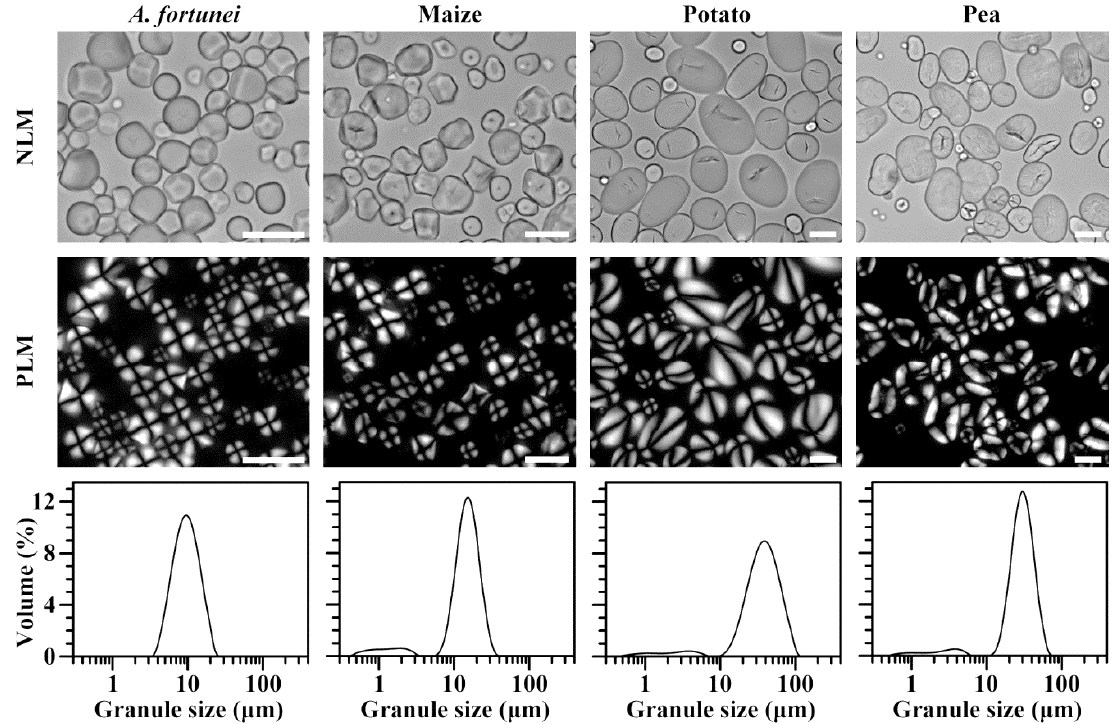
Figure 1. Morphology of starch under normal light microscope (NLM) and polarized light microscope (PLM) and granule size distribution. Scale bar = 20 μ m.